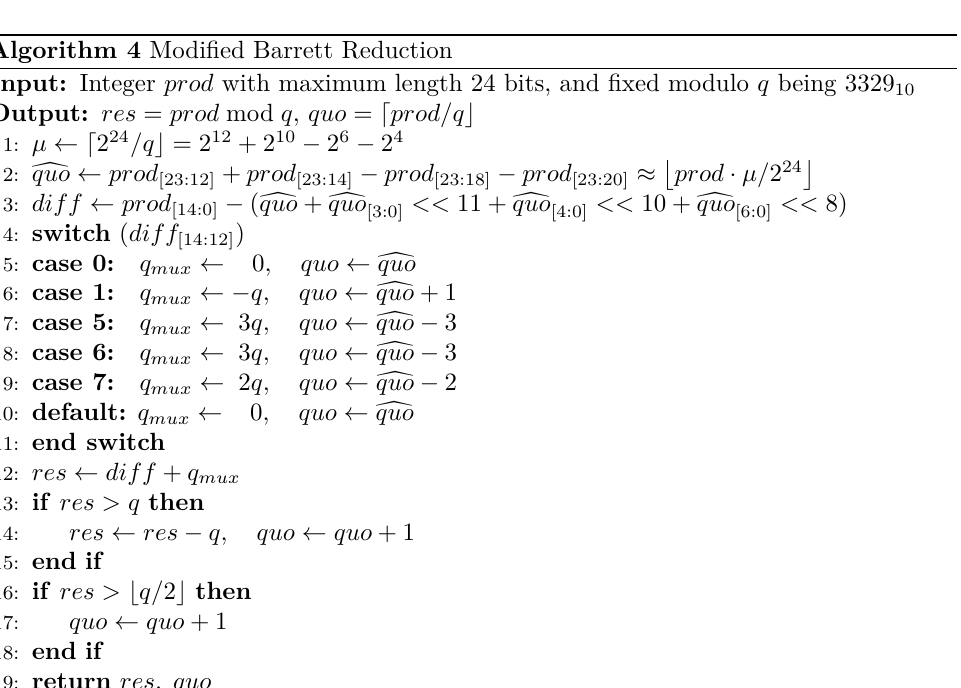
338 A Compact Hardware Implementation of CCA-Secure Key Exchange Mechanism CRYSTALS-KYBER on FPGA